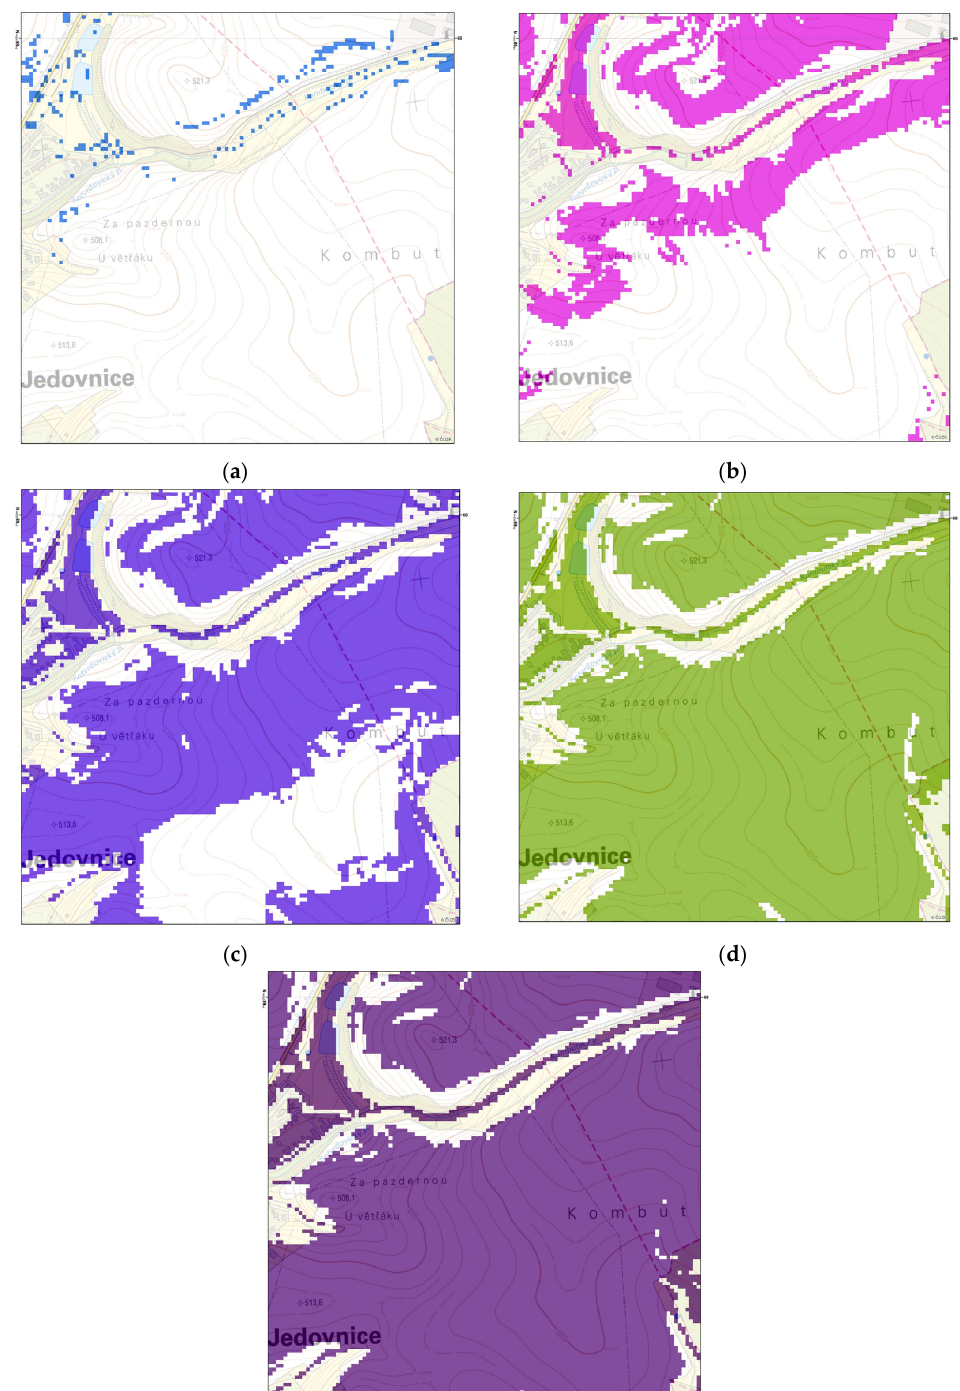
13 Figure 13. Intersection distribution of the same suitability values in the AOI area in the Jedovnice area: ( a ) for the value 10,( b ) for the values 10 a 9, ( c ) for the values 10, 9 a 8, ( d ) for the values 10, 9, 8 a 7, ( e ) for the values 10, 9, 8, 7 a